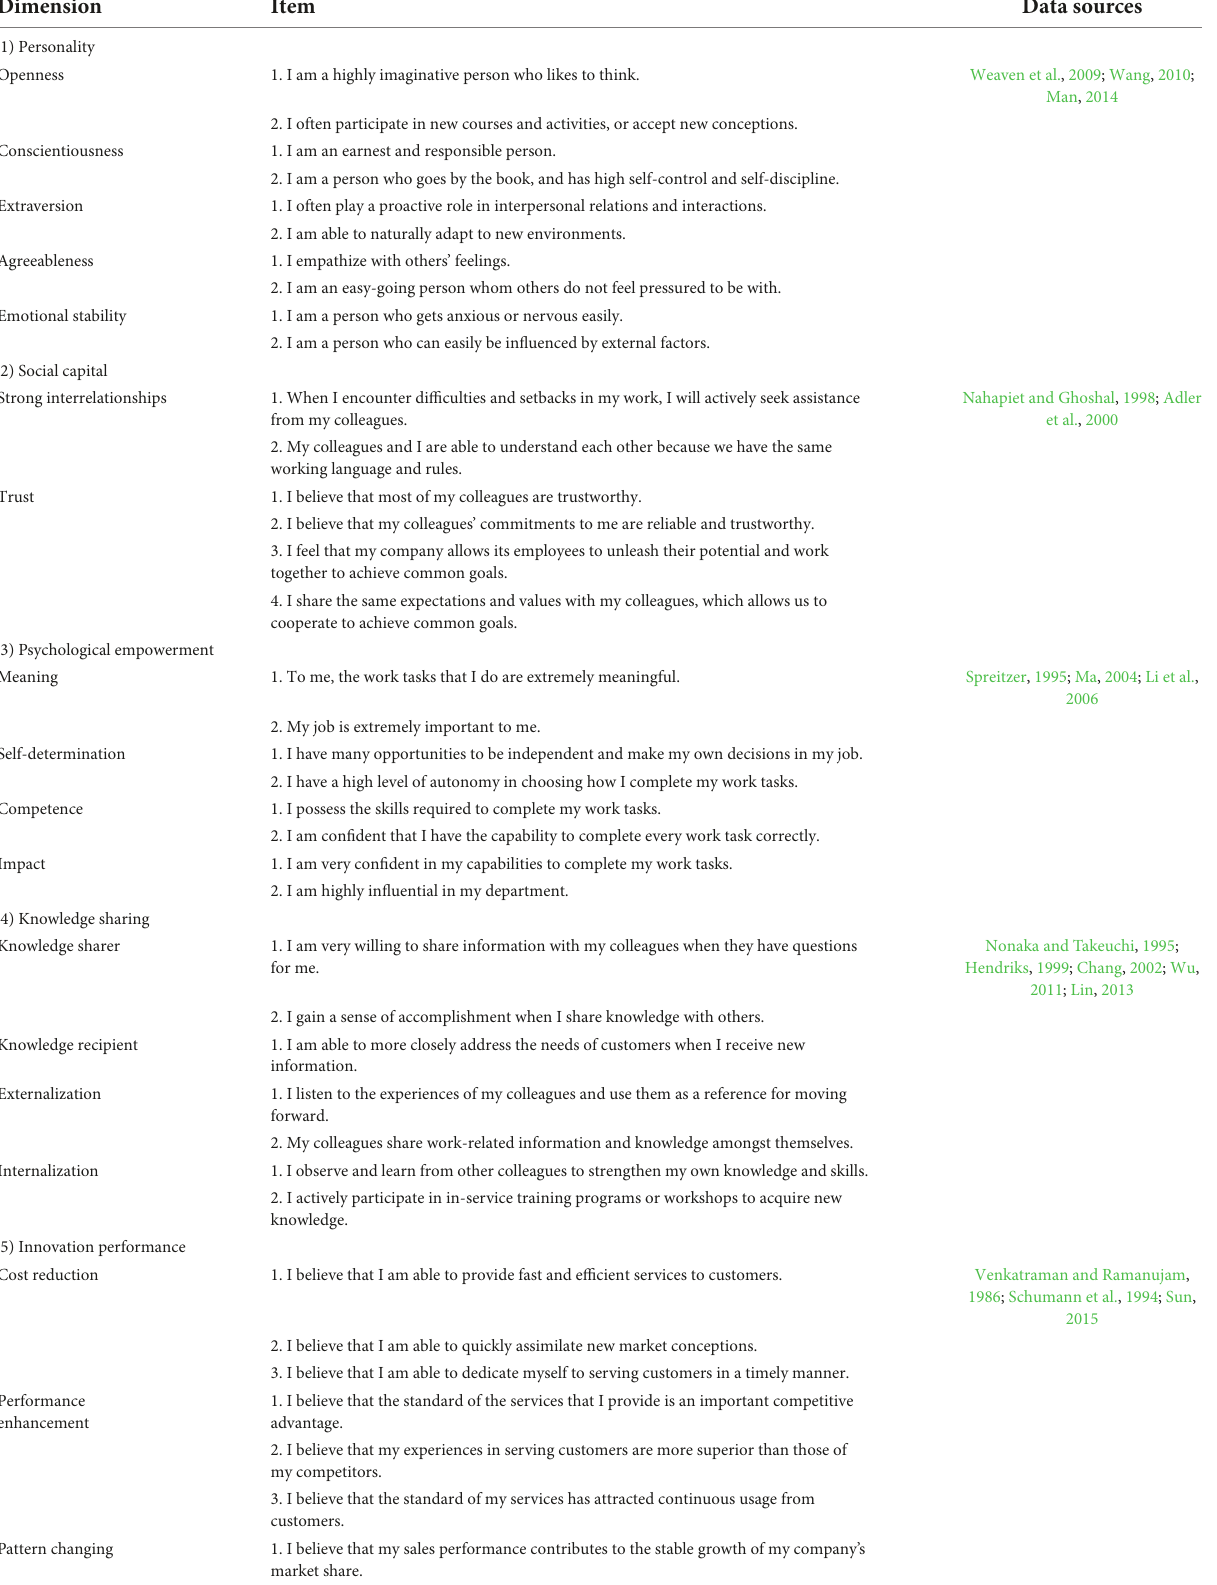
TABLE 1 Questionnaire items and data sources. Dimension Item Data